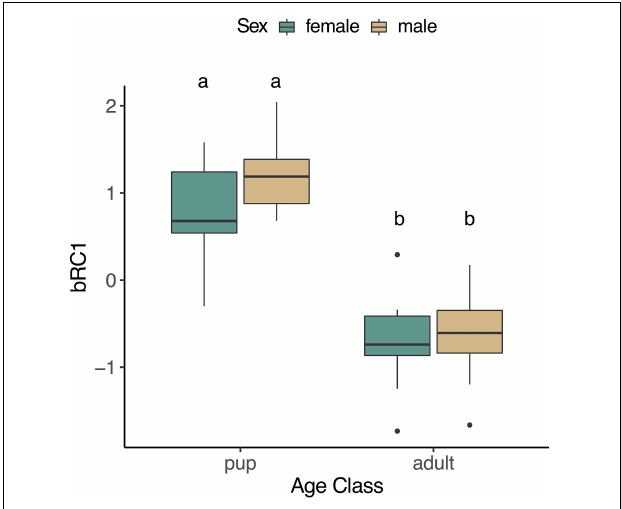
FIGURE 8 | Expression of rotated component bRC1 ( HMOX2 , PRDX1 , TLR4 , CCL4 , TNFA ) in whole blood of NES was higher in pups than adults ( F 1 , 31 = 73.41, p < 0.05).